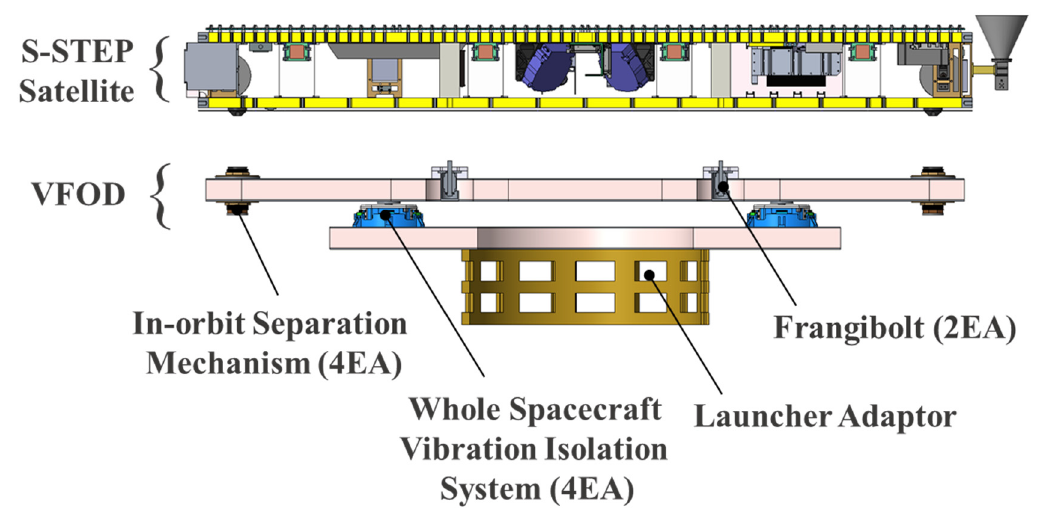
Figure 6. Exploded cross-sectional view of the S-STEP system, VFOD, and launcher adaptor.